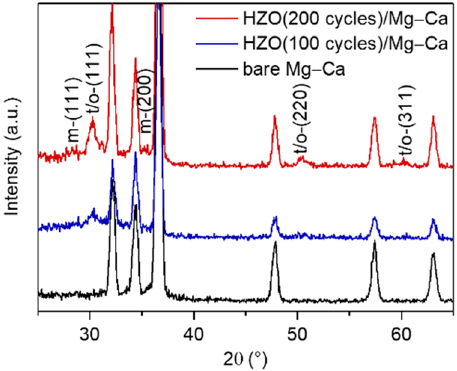
Figure 4. XRD patterns of bare Mg–Ca alloy and Mg–Ca alloy with HZO films of 100 and 200 cycles. The label of m-, t-, and o- are corresponding to the monoclinic structure, tetragonal structure, and orthorhombic structure, respectively.